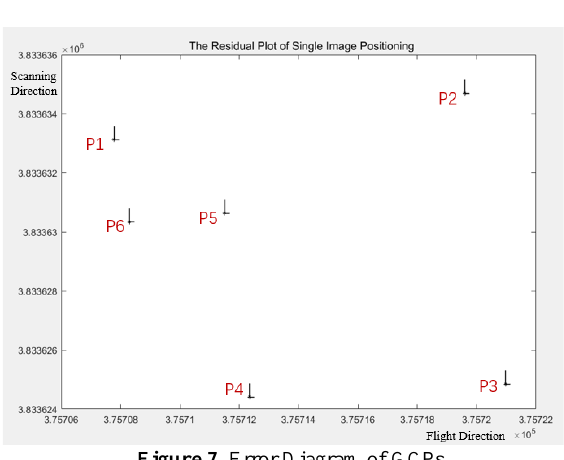
Figure 7 . Error Diagram of GCPs.